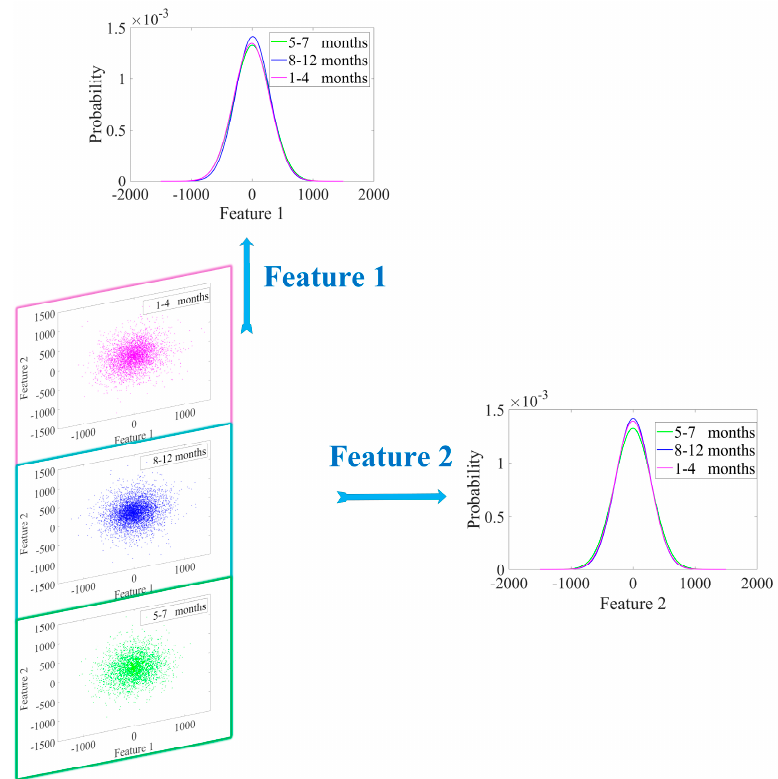
Figure 7. Feature probability distribution of an inverter in different periods.